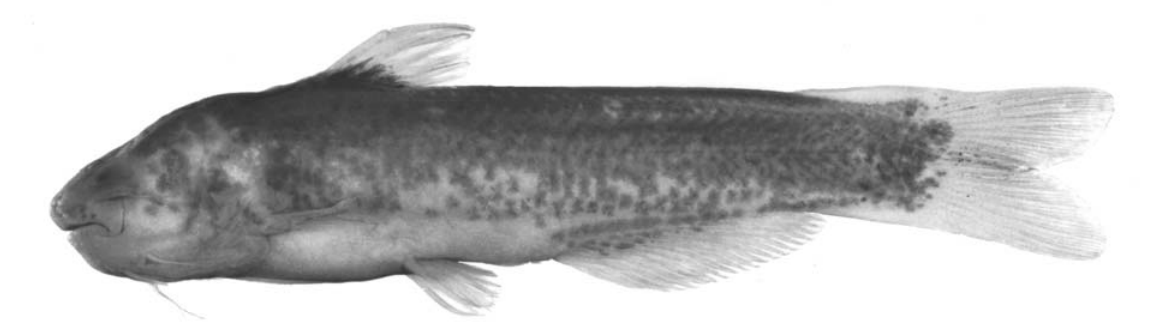
Fig. 4 . Cetopsidium morenoi, INHS 61937, 40.0 mm SL; Venezuela, Guarico, río San Bartolo (8 o 03’N, 66 o 42’W).